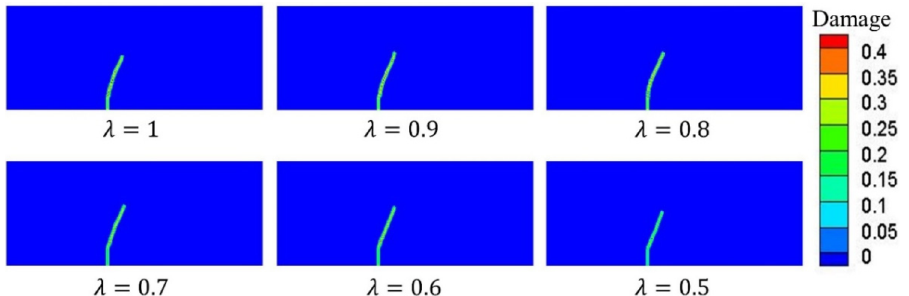
Figure 9. Contour plots of the crack paths for the additive manufactured orthotropic materials at time t = 6.0 × 10 − 4 s.